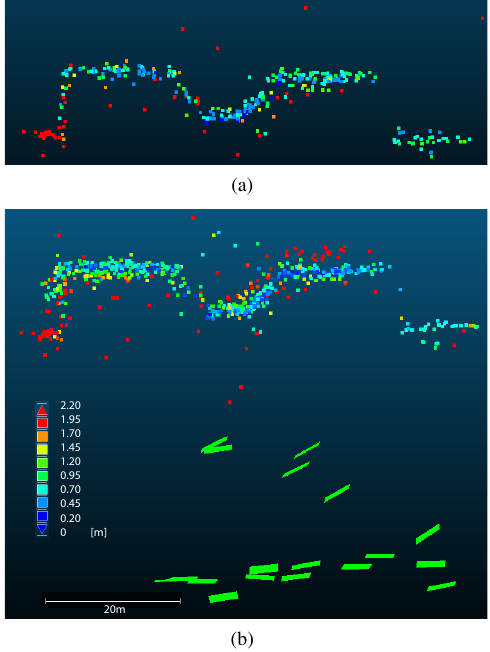
Figure 2: Vertical view of the resulting point cloud after orienting 10 images (a) and after orienting 20 images (b) using our algo- rithm. The positions of the image planes are represented by the green parallelograms in (b). Variations in size are caused by dif- ferent viewing angles. Note that some camera stations only differ in height, so that the respective parallelograms are superimposed in (b). The point colours encode their point-to-point distances to the model computed using PhotoModeler .